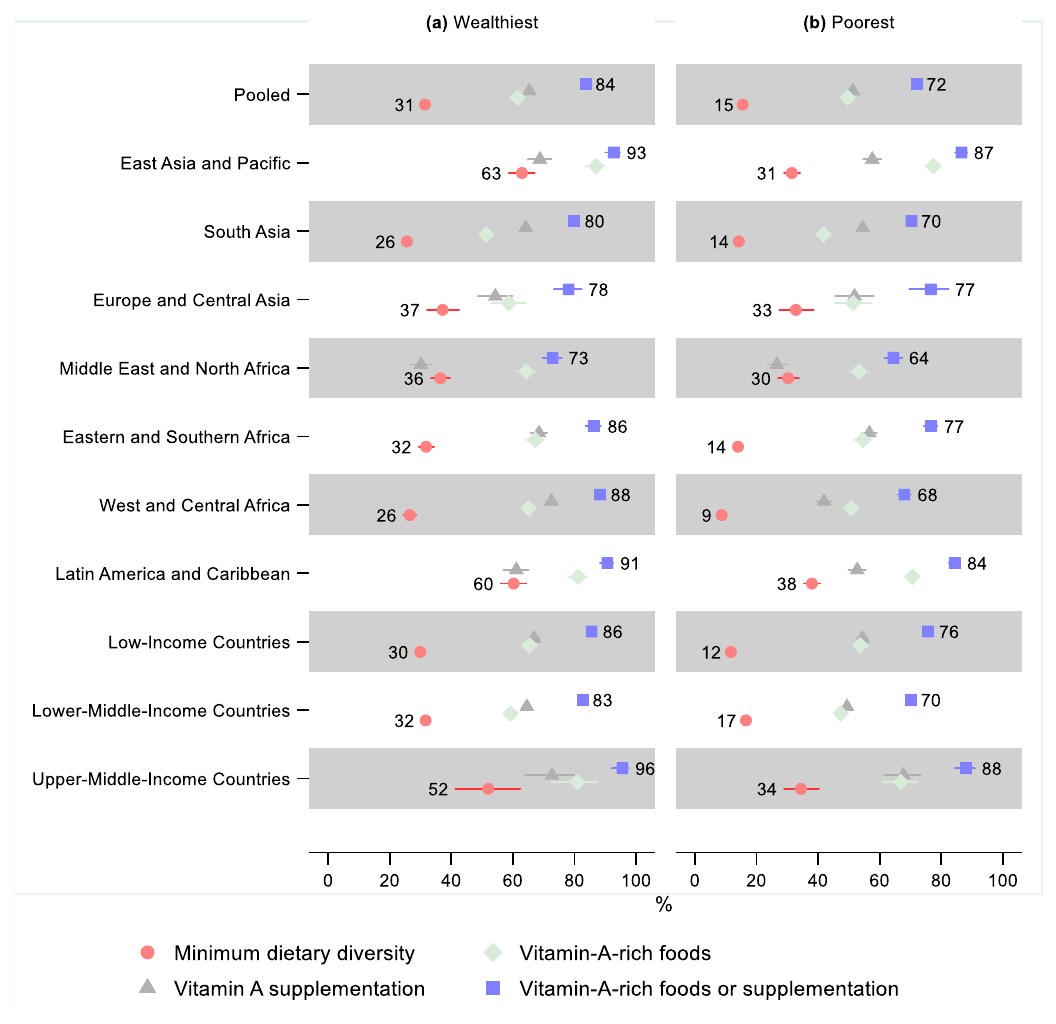
Figure 5. Percentage of children 6–23 months old that received the minimum dietary diversity, vitamin-A-rich foods, vitamin A supplementation, and either vitamin-A-rich foods or vitamin A supplementation in low- and middle-income countries by living standards. Notes: 95% confidence intervals are shown. Some confidence intervals may be narrower than the symbol for the estimate and therefore not visible. See Tables S9–S12 in the Supplement for the tabulated estimates and confidence intervals. See Figures S9–S12 in the Supplement for the plotted relative